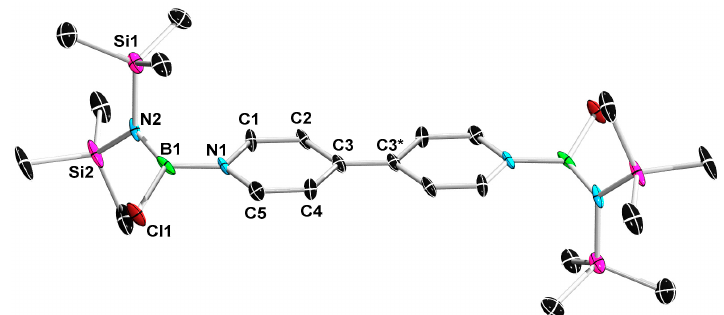
Figure 3. Molecular structure of 13a in the solid state (ellipsoids set at 50% probability). Selected bond lengths (Å) and angles (°) for 13a : B1–N1 1.459(8), B1–N2 1.392(10), Si1–N2 1.757(5), Si2–N2 1.770(5),